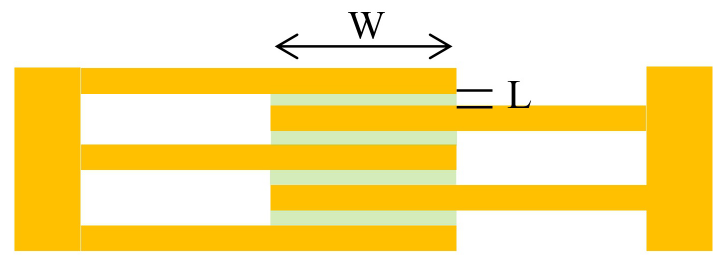
Figure 4. P-type OTFT layout. ( a ) side view and ( b ) lateral view.